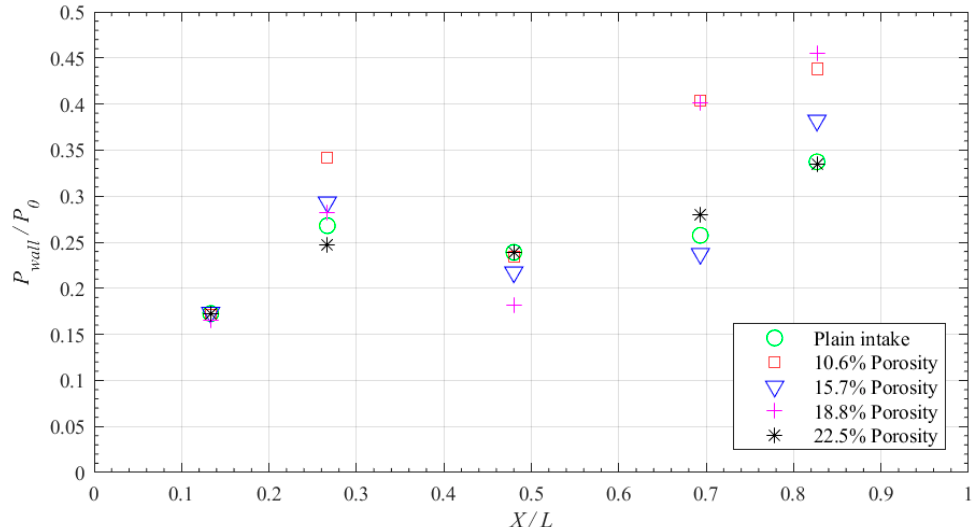
Figure 13. Static pressure variation along the intake-core due to wall ventilation at R c = 1.19.